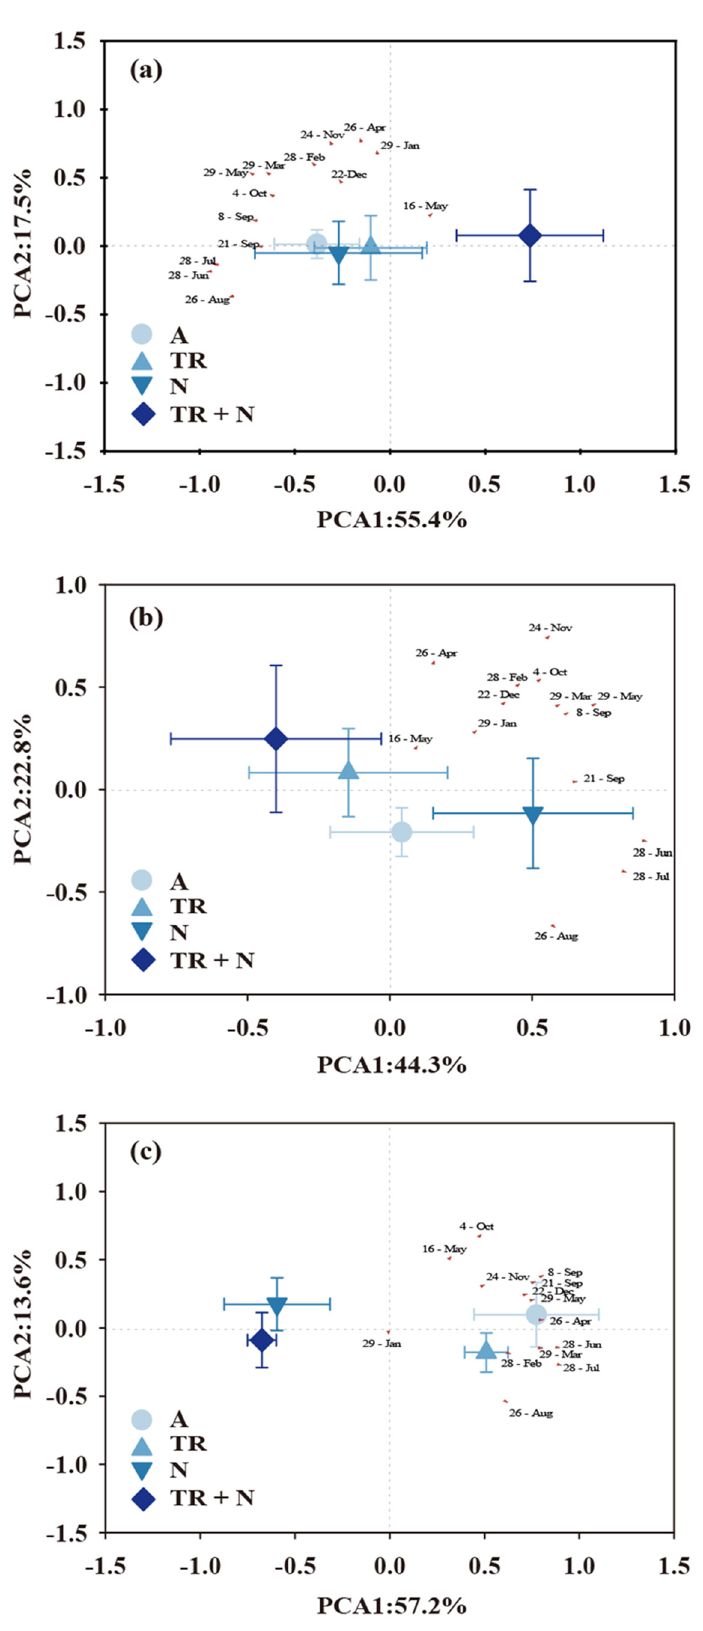
Figure 4. Principle components analysis (PCA) of soil respiration (Graph ( a )), soil autotrophic respiration (Graph ( b )) and soil heterotrophic respiration (Graph ( c )) under ambient (A), throughfall reduction (TR), N addition (N) and throughfall reduction and N addition (TR + N) treatments.